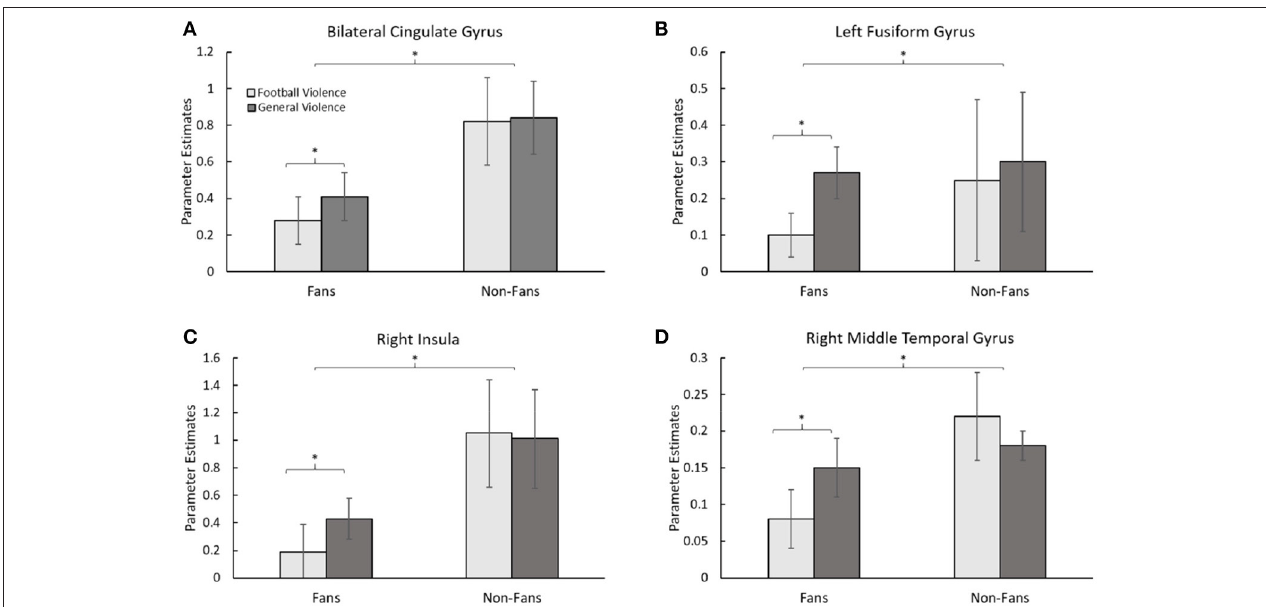
FIGURE 3 | Functional differences in Fans vs. Non-Fans. Parameter estimates of ROI activation for football-related violence and general violence across fan classification. (A) shows a comparison of the activation in the bilateral cingulate gyrus. (B) shows a comparison of the activation in the left fusiform gyrus. (C) shows a comparison of the activation in the right insular cortex. (D) shows a comparison of the activation in the right middle temporal gyrus. For all the four regions, the Fan group showed significantly ( p < 0.05, FDR corrected) less activation for football violence as compared to general violence. Also, all regions showed significantly ( p < 0.05, FDR corrected) less activation in the Fan, as compared to the Non-Fan group when violence type was combined. The asterisk represents a difference of p < .05 between the